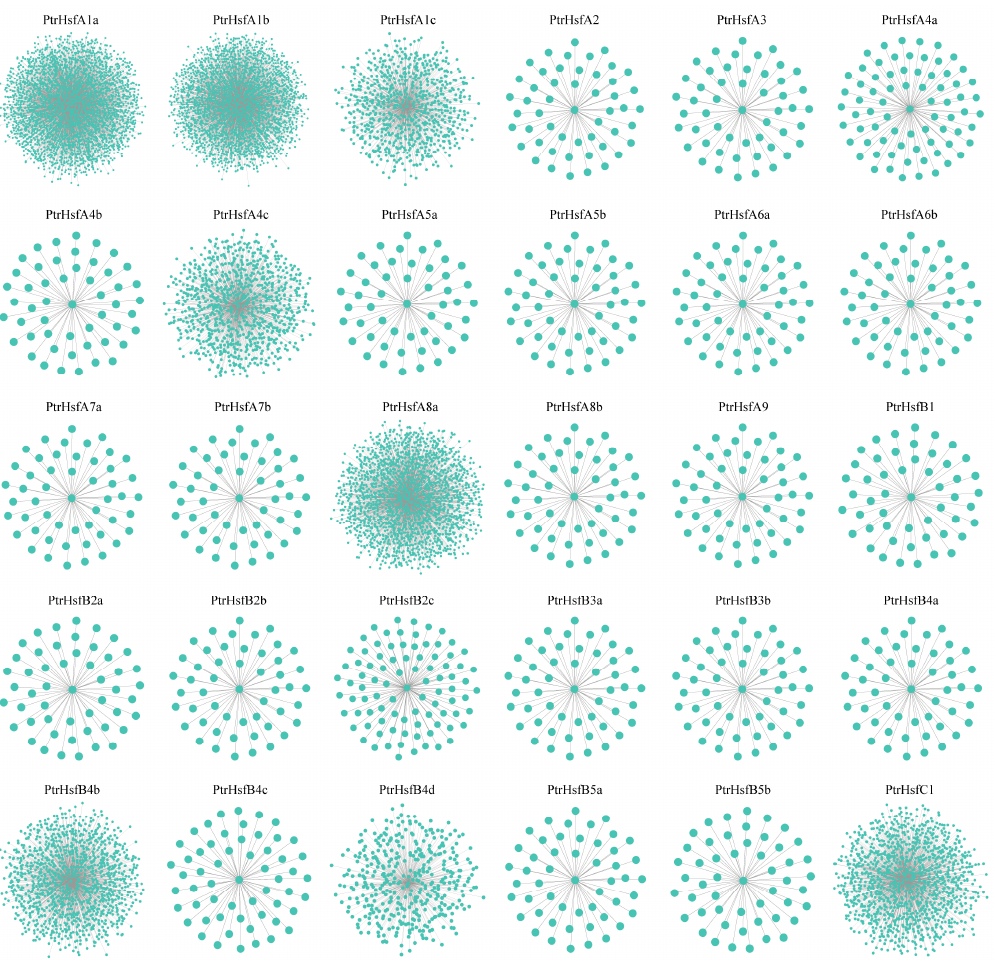
Figure 10. TF-centered co-expression networks of 30 poplar HSF genes. Dots represent genes, and lines indicate genes with co-expression relationships.